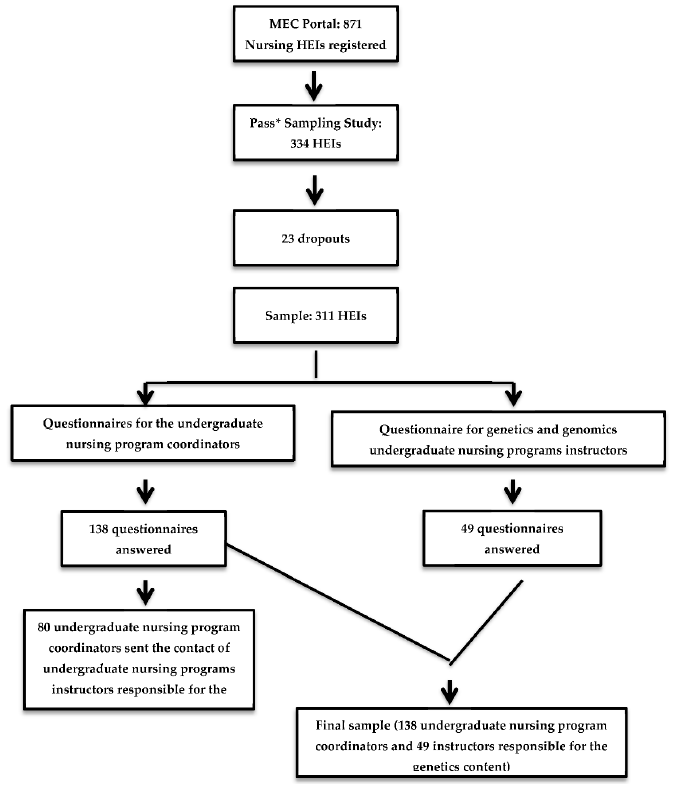
Figure 1. Recruitment flowchart. Abbreviations: MEC, Brazilian Ministry of Education; HEIs, Higher Education Institutions; PASS*, Power Analysis and Sample Size.